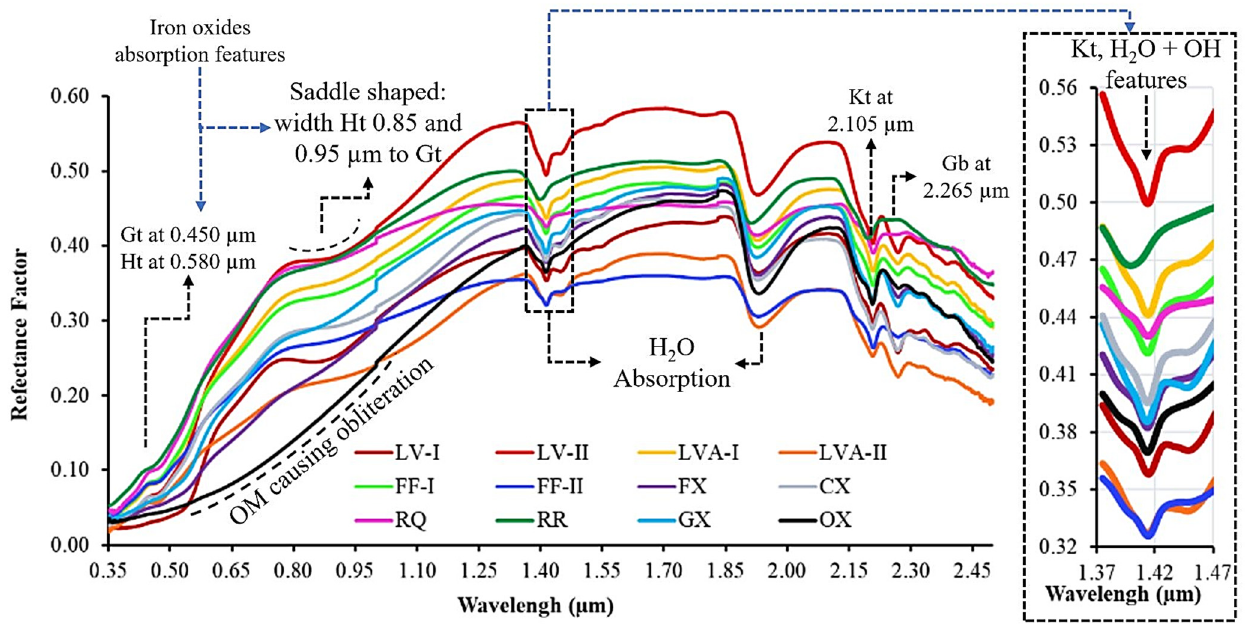
Figure 3. Spectral library with the endmembers in the studied region, highlighting the following absorption features: Kt feature at 1.40 μ m and organic material effect on OX spectra. Other features absorption features: Kt feature at 1.40 µ m and organic material effect on OX spectra. Other features also are pointed, such as Ht: Hematite, Gt: Goethite, Kt: Kaolinite, Gb: Gibbsite. also are pointed, such as Ht: Hematite, Gt: Goethite, Kt: Kaolinite, Gb: